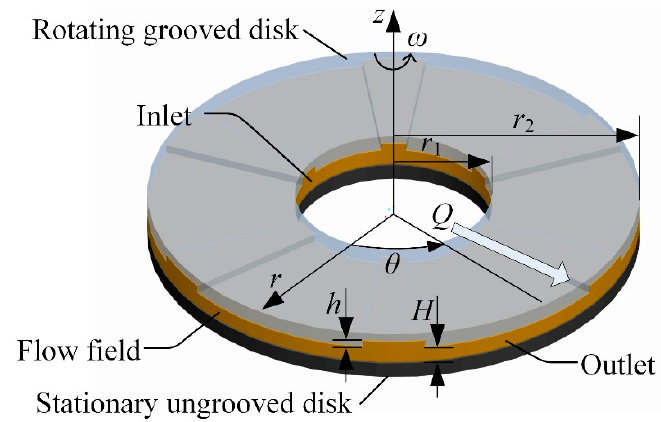
Figure 1. Schematic of the grooved rotating-disk system.